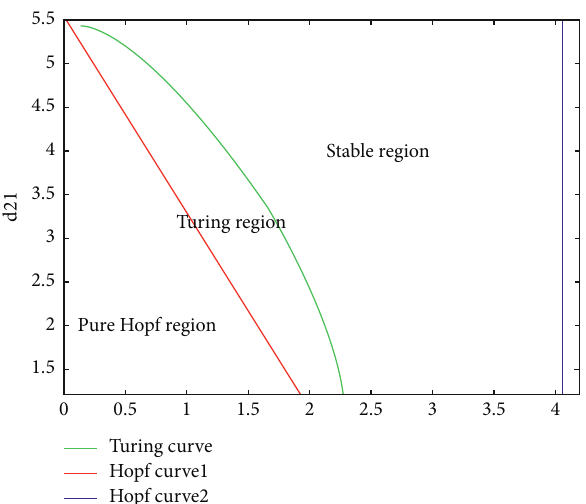
Figure 9: Bifurcation diagram in d